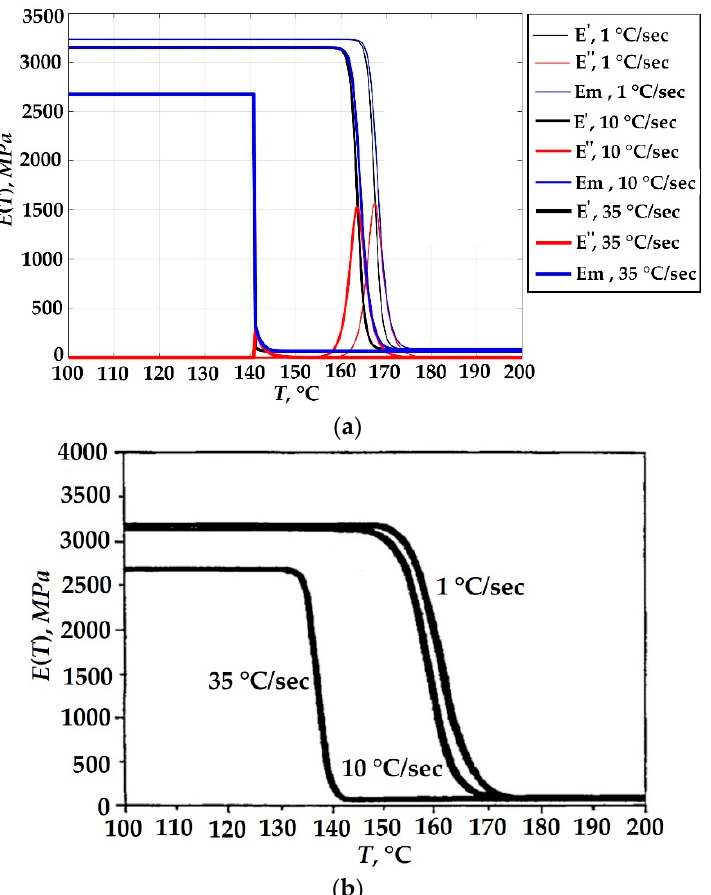
Figure 3. Temperature dependence of the complex PEEK module during cooling at different speeds: ( a ) calculation according to (32), where the blue lines are 𝐸 ′ , red lines are 𝐸 ′′ , and black lines are amplitude E m ; ( b ) experimental data of the paper [7].